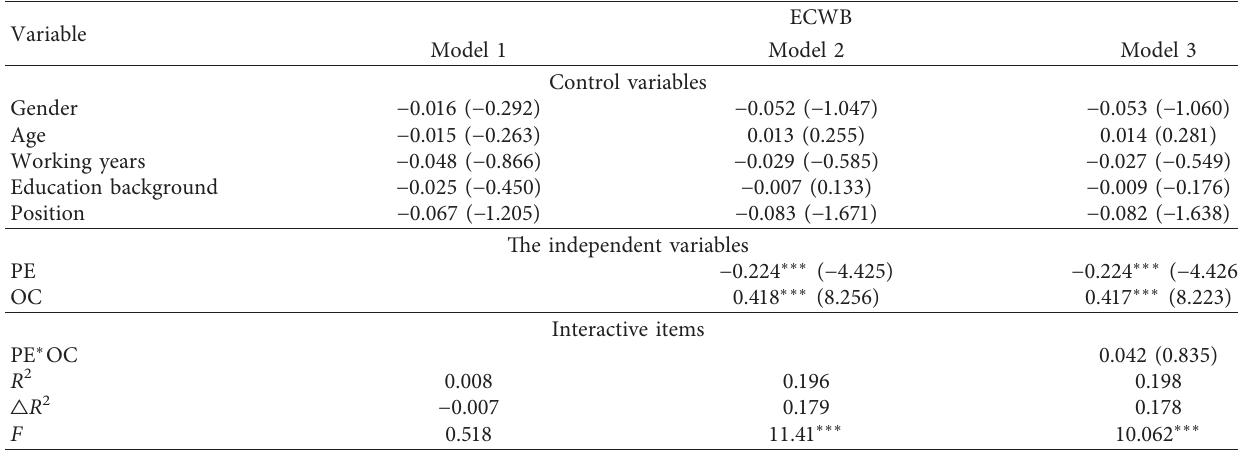
Table 8: Examine the moderating effect of organizational commitment on positive emotion and counterproductive behavior of